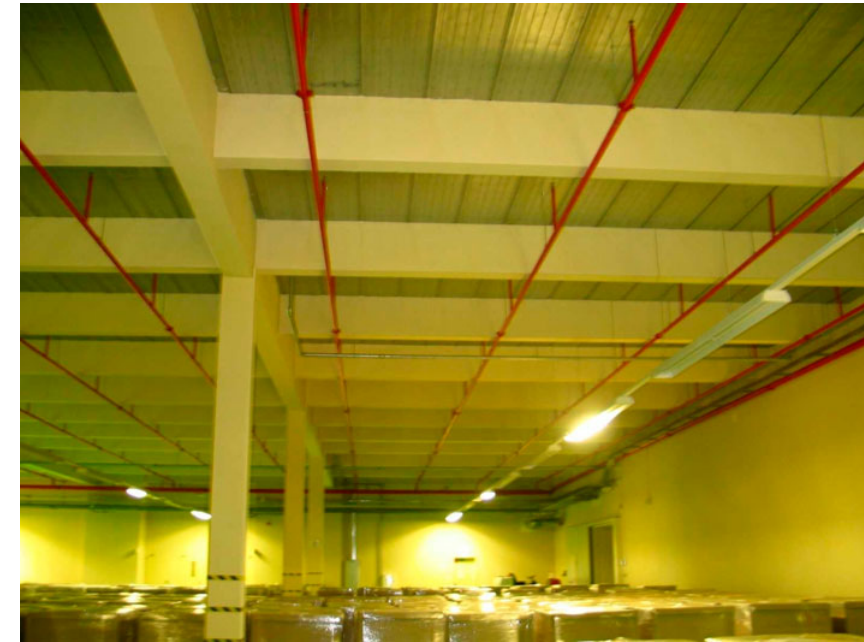
Fig. 2. View of the system of main and secondary floor